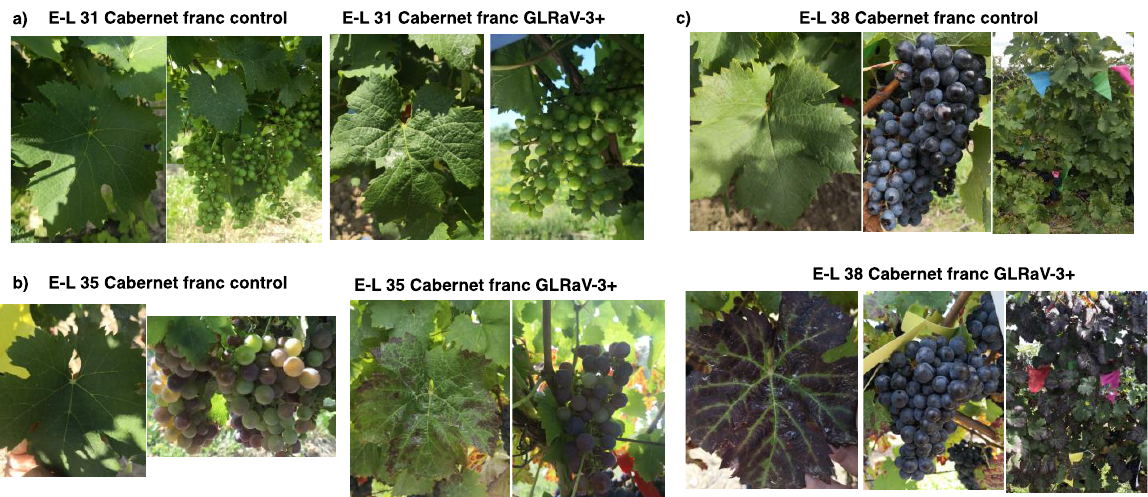
Figure 1. Symptom progression of grapevine leafroll-associated virus 3 (GLRaV-3) infection in leaves and berries of Cabernet franc. The three developmental stages of grapevine were identified based on the modified Eichhorn and Lorenz system (Coombe, 1995; Dry and Coombe, 2004). ( a ): E-L31: pea-sized berry (photographs taken on 23 July 2019); ( b ) E-L 35: veraison (11 September 2019); ( c ) E-L 38: harvest (11 October 2019).